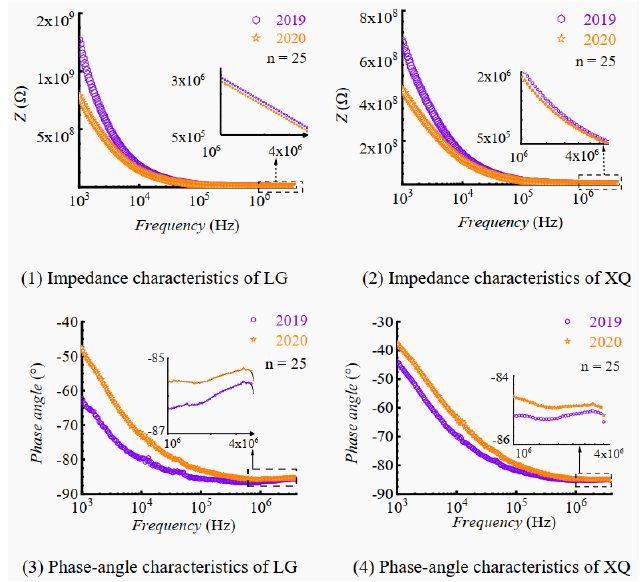
Figure 5. Electrical impedance spectroscopy of seeds with different vigor (reprinted from Ref. [1]).